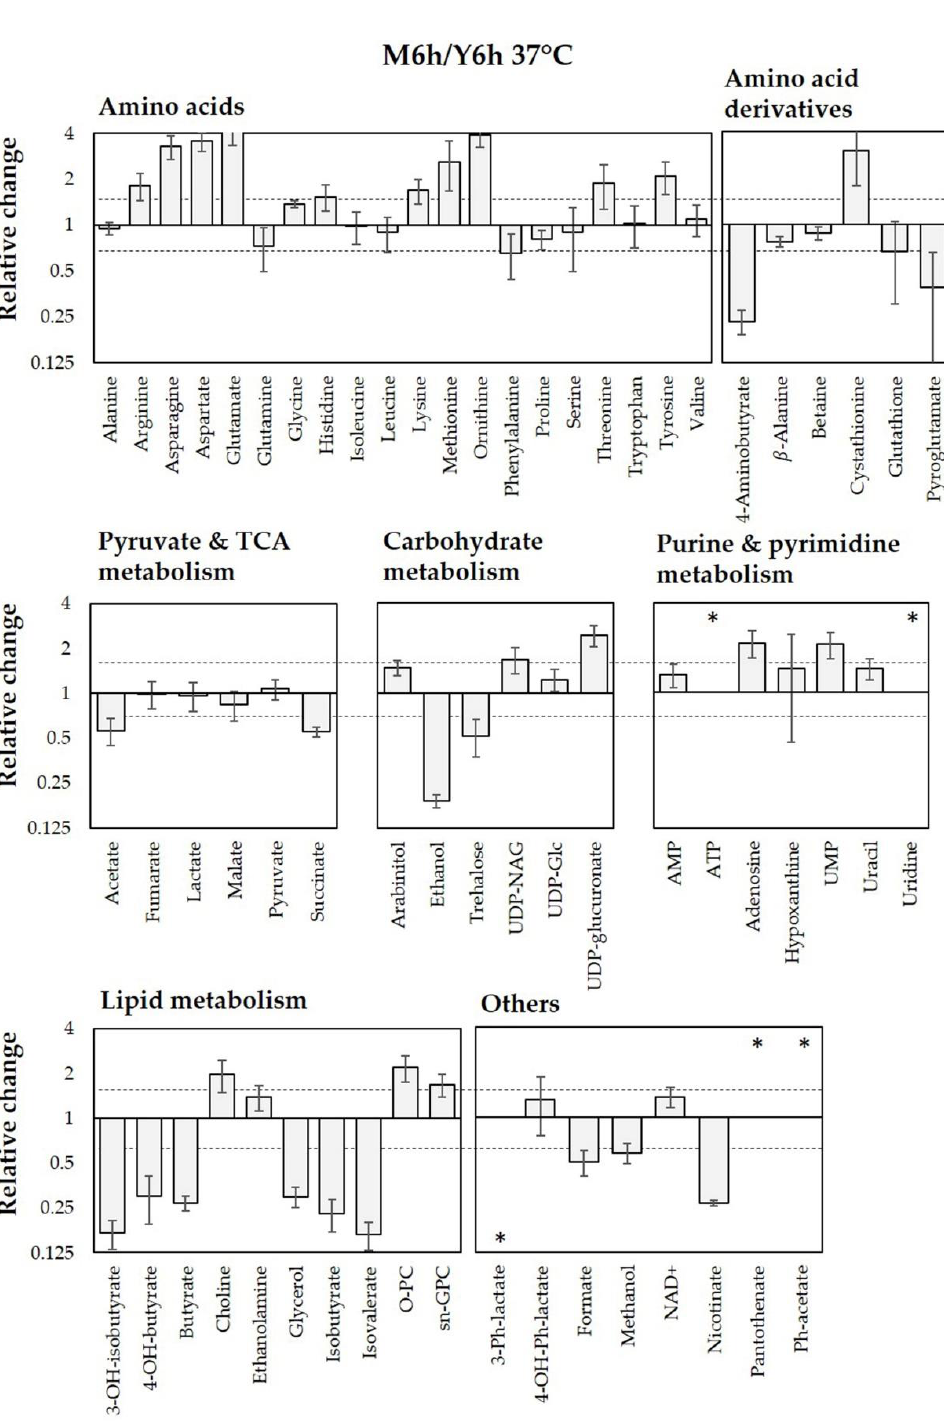
Figure 4. Relative change in intracellular metabolite concentrations after 6 h of incubation at 37 °C in M199 (M6h) compared to YPD (Y6h). Concentrations were normalized per total cell number and metabolite median concentration. Relative changes are expressed as metabolites’ concentration ratio (M6h/Y6h). Ratios higher than 1.5 or lower than 0.66 (indicated by dashed lines) were considered representative of significant changes. TCA: tricarboxylic acid; O-PC: O-phosphocholine; sn-GPC: sn -glycerophosphocholine; UDP-NAG: uridine diphosphate-N-acetylglucosamine; UDP-Glc: uridine diphosphate-glucose; UMP: uridine monophosphate; Ph: phenyl; OH: hydroxy. Y axis is in log 2 scale. The asterisk (*) indicates that the metabolite is present only in one of the two culture conditions (M199 if in the upper part, YPD if in the lower part of the graph).